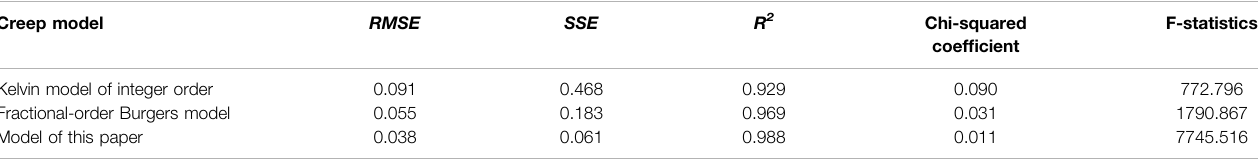
TABLE 3 | Evaluation results of different